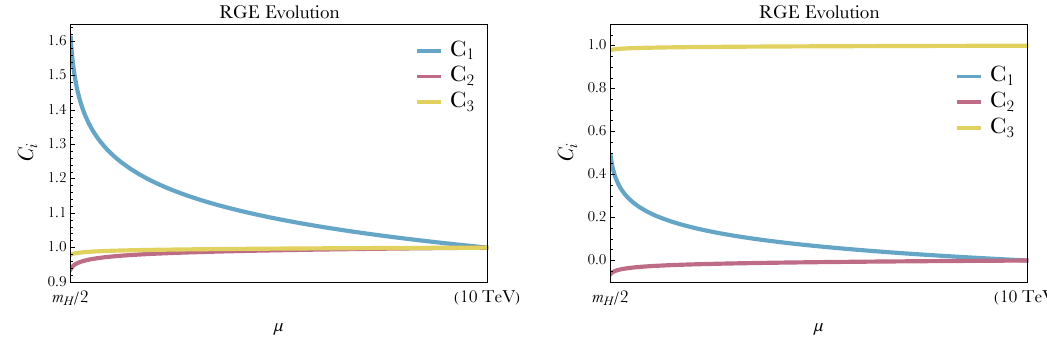
Figure 2 . Renormalization group evolution of the three Wilson coe(cid:14)cients between 10 TeV and m H = 2 in two scenarios. Left: C 1 = C 2 = C 3 = 1 at (cid:22) = 10 TeV. Right: C 1 = C 2 = 0 and C 3 = 1 at (cid:22) = 10